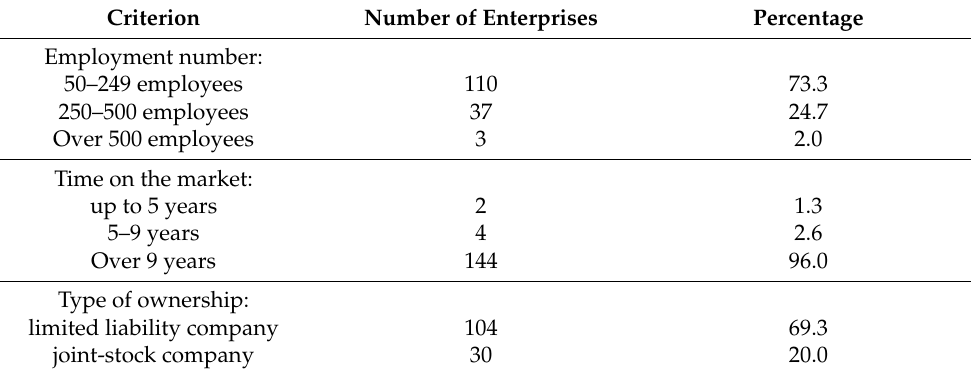
Table 2. Profiles of studied enterprises (N =